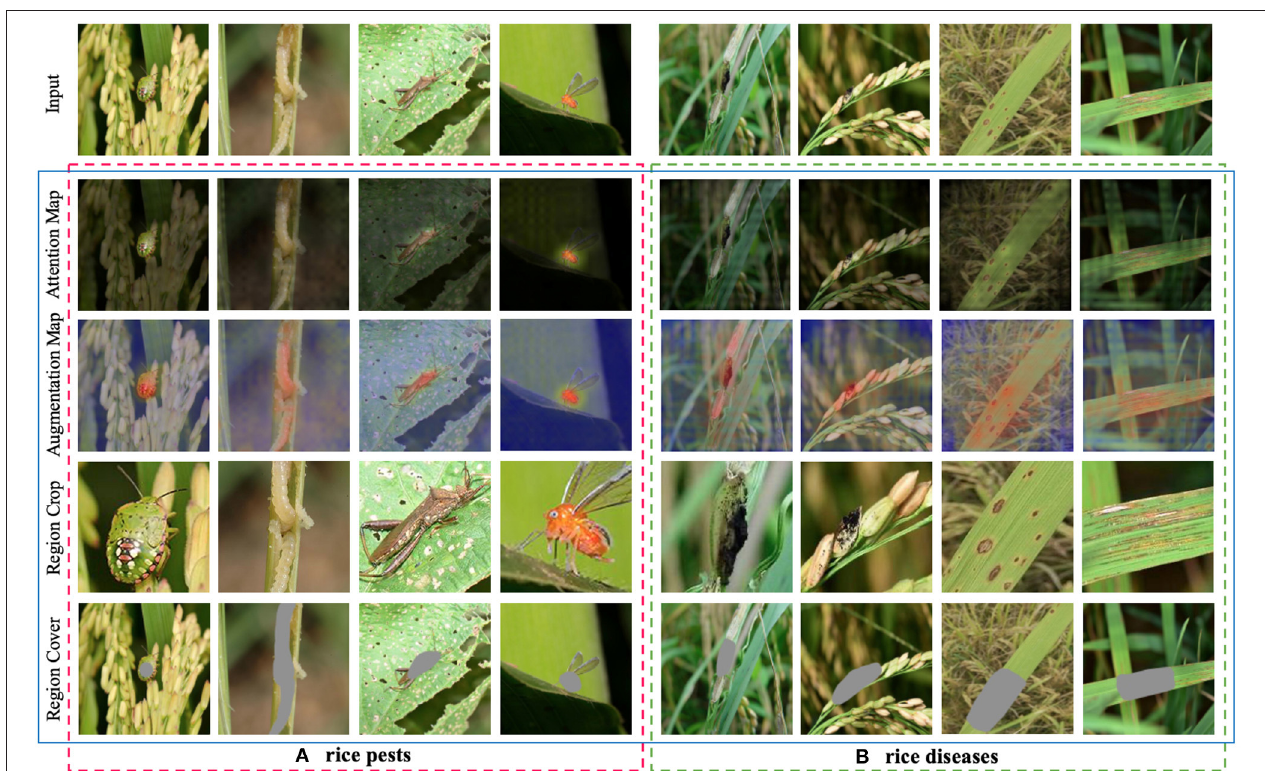
FIGURE 5 | Visualization of the effect of image augmentation in CRN on rice pest and disease images. (A) rice pests. (B) rice